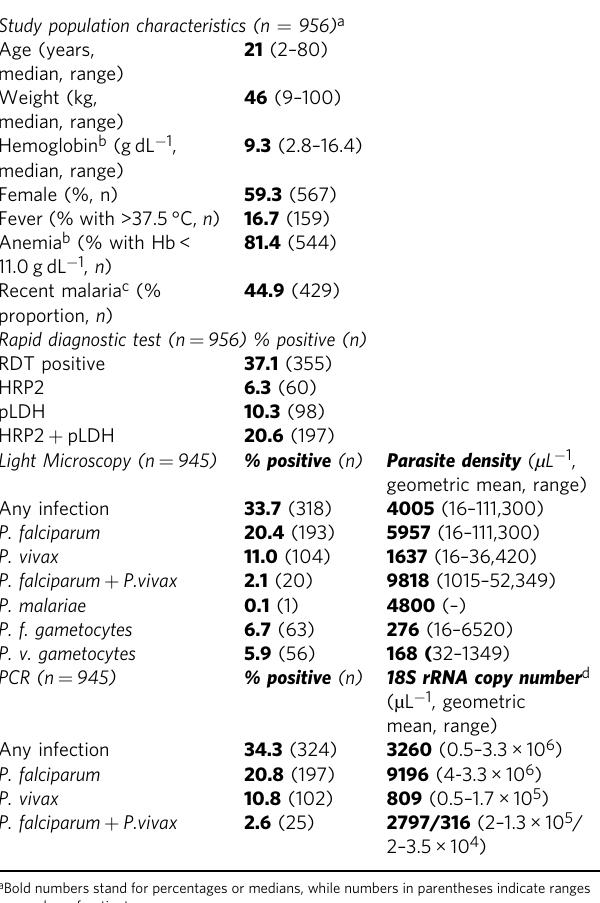
Table 1 Characteristics of the study population and infection data ( n = 956).